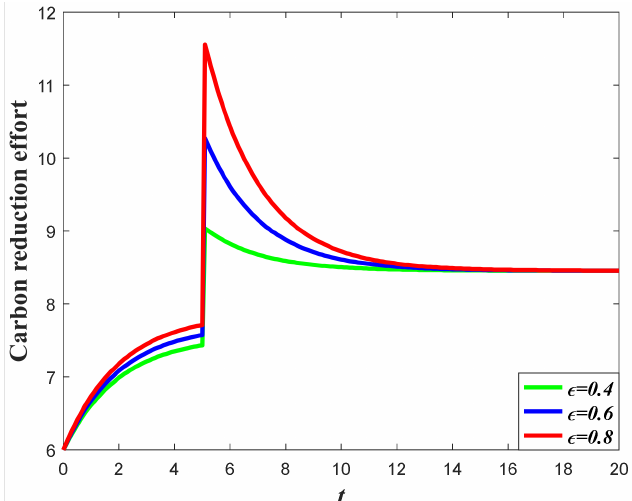
Figure 6. Impacts of ε on carbon reduction